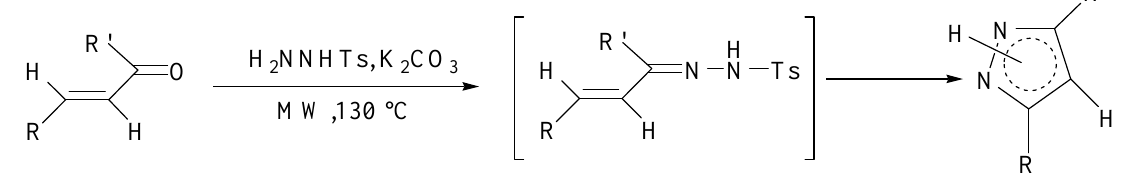
Scheme 3. Reaction scheme for the synthesis of pyrazoles a-c starting directly from carbonyl precursors.